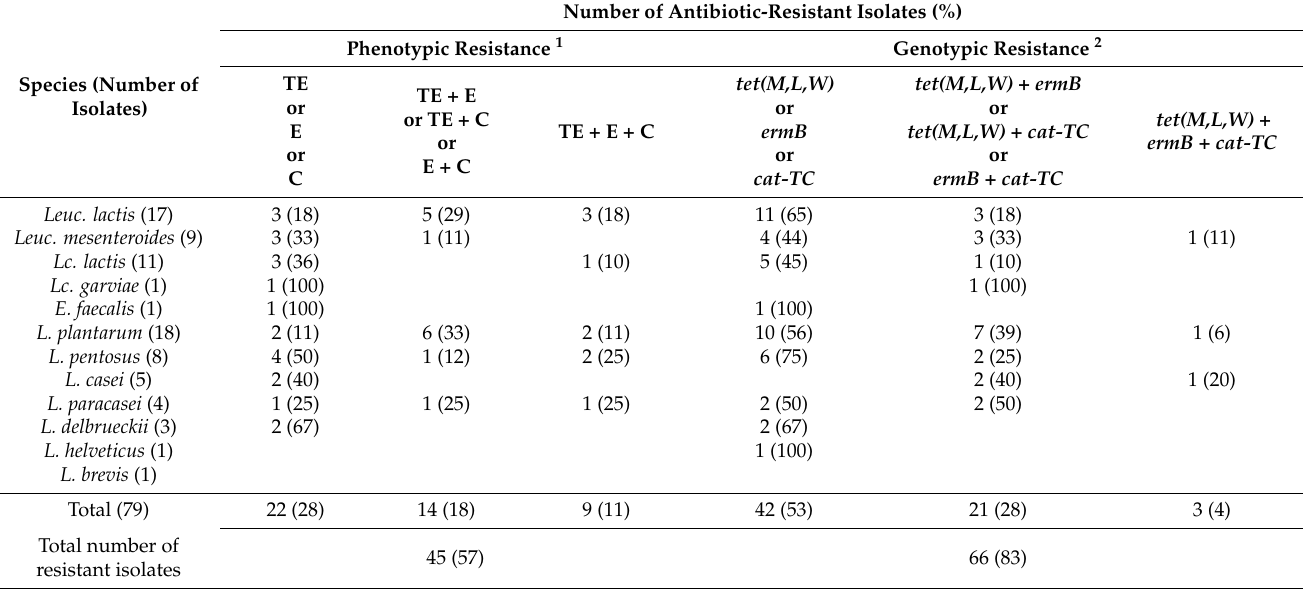
Table 5. Distribution of phenotypic and genotypic antibiotic resistance in lactic acid bacteria isolated from regional cheeses produced in